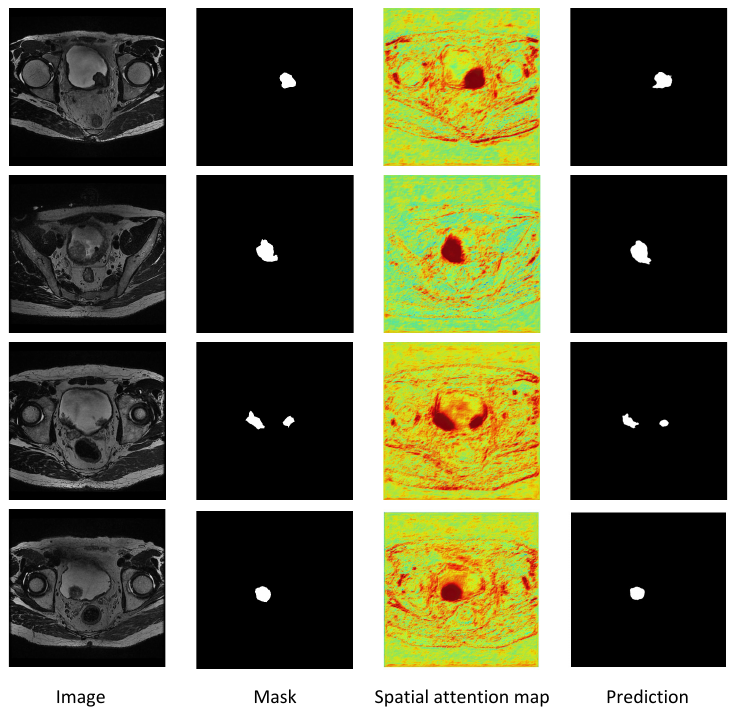
Figure 7. Visualization of the input image, mask, spatial attention map and prediction